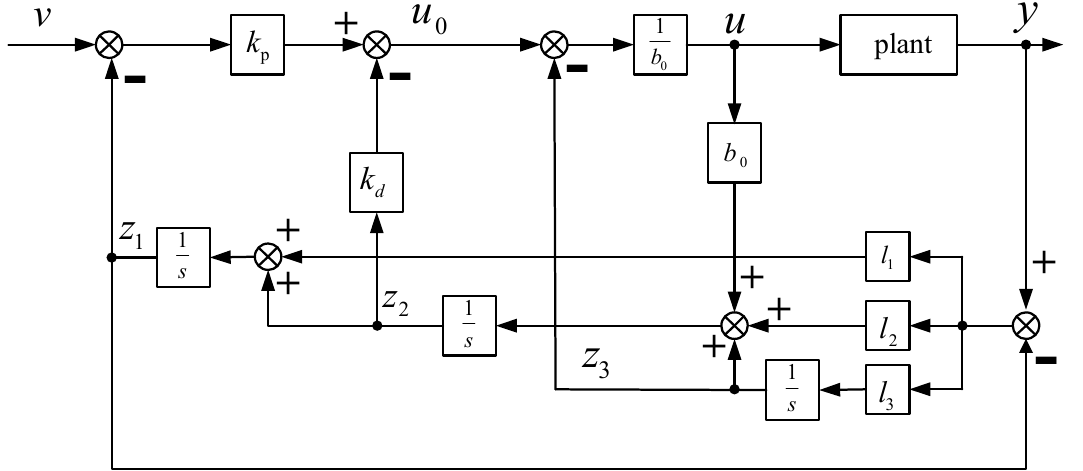
Figure 5. Second-order Linear Active Disturbance Rejection Control (LADRC) controller structure.